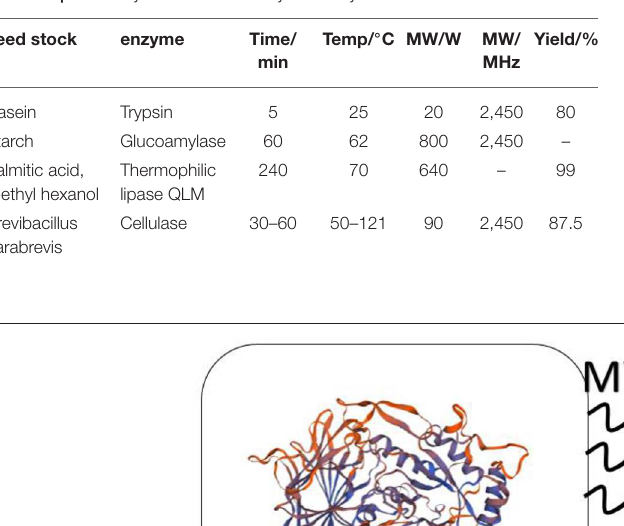
TABLE 4 | Summary of microwave enzyme